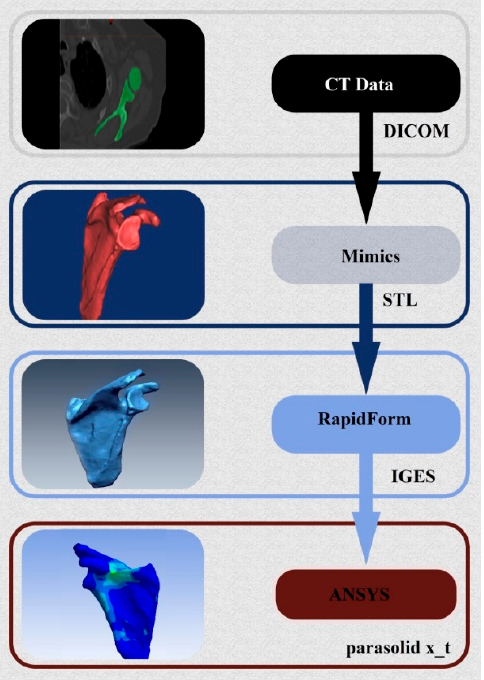
Figure 1. Illustration of the 3D reconstruction procedure of the bone structure of the shoulder.